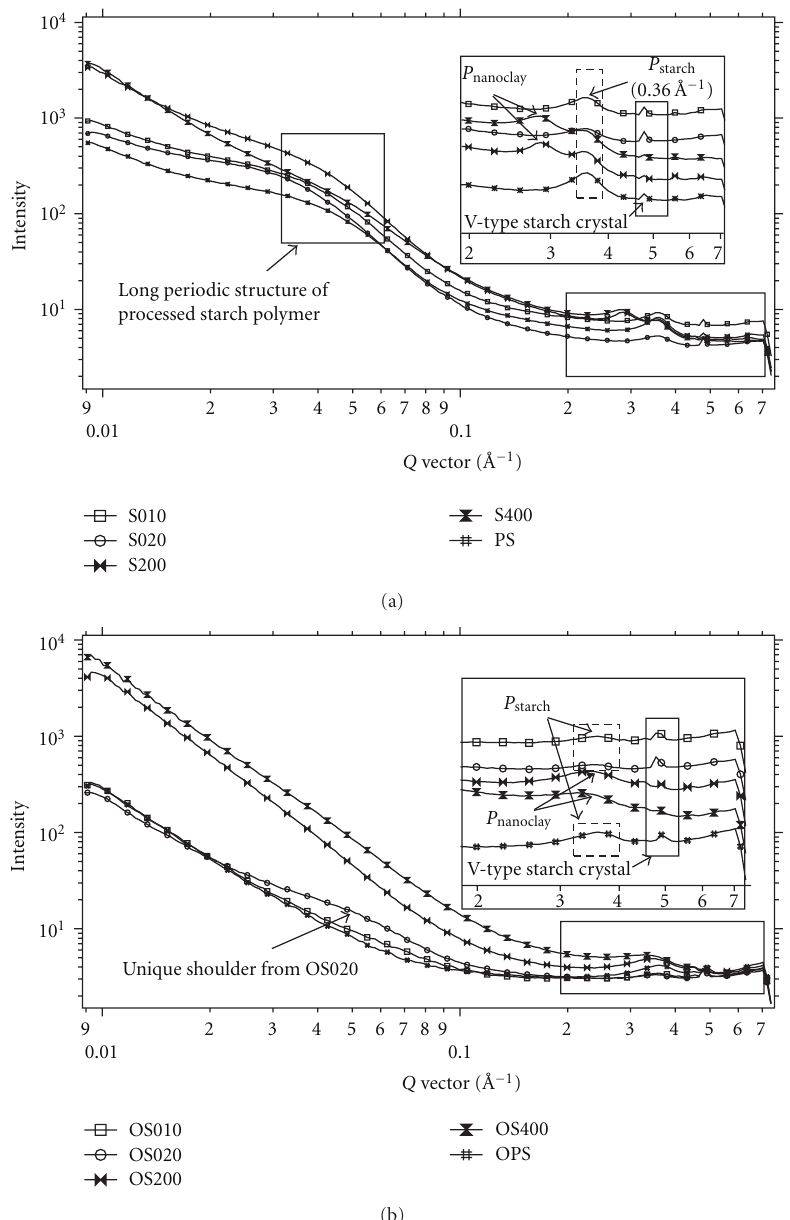
Figure 2: SAXS profiles for pure starch, starch/sorbitol, and starch/nanoclay samples (a) high-moisture-content and (b) low-moisture- content samples generated from NIKA data processing